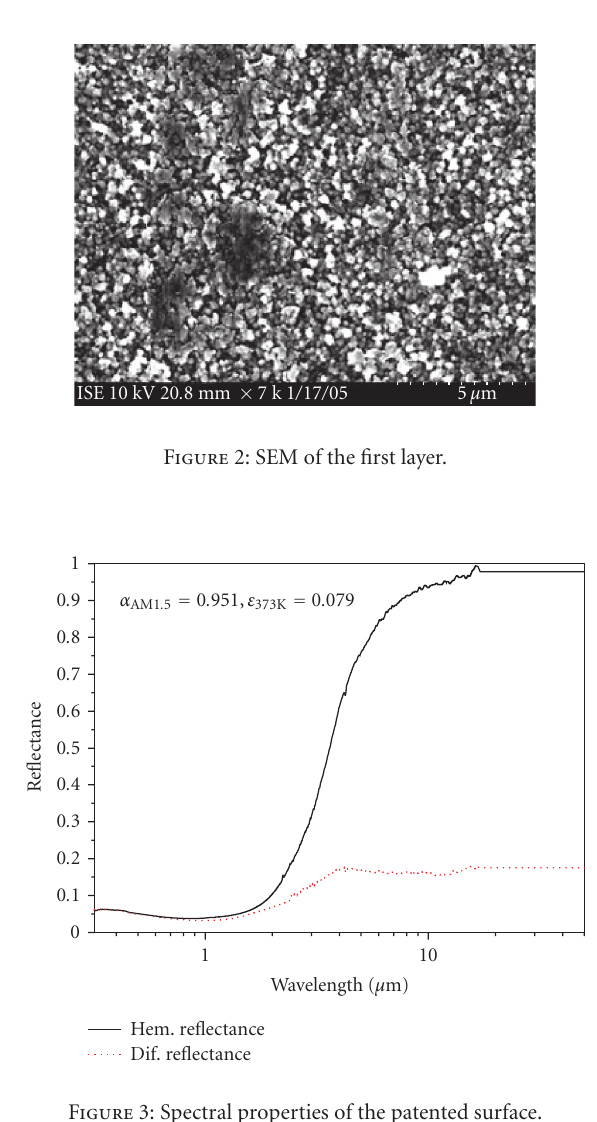
Figure 3: Spectral properties of the patented